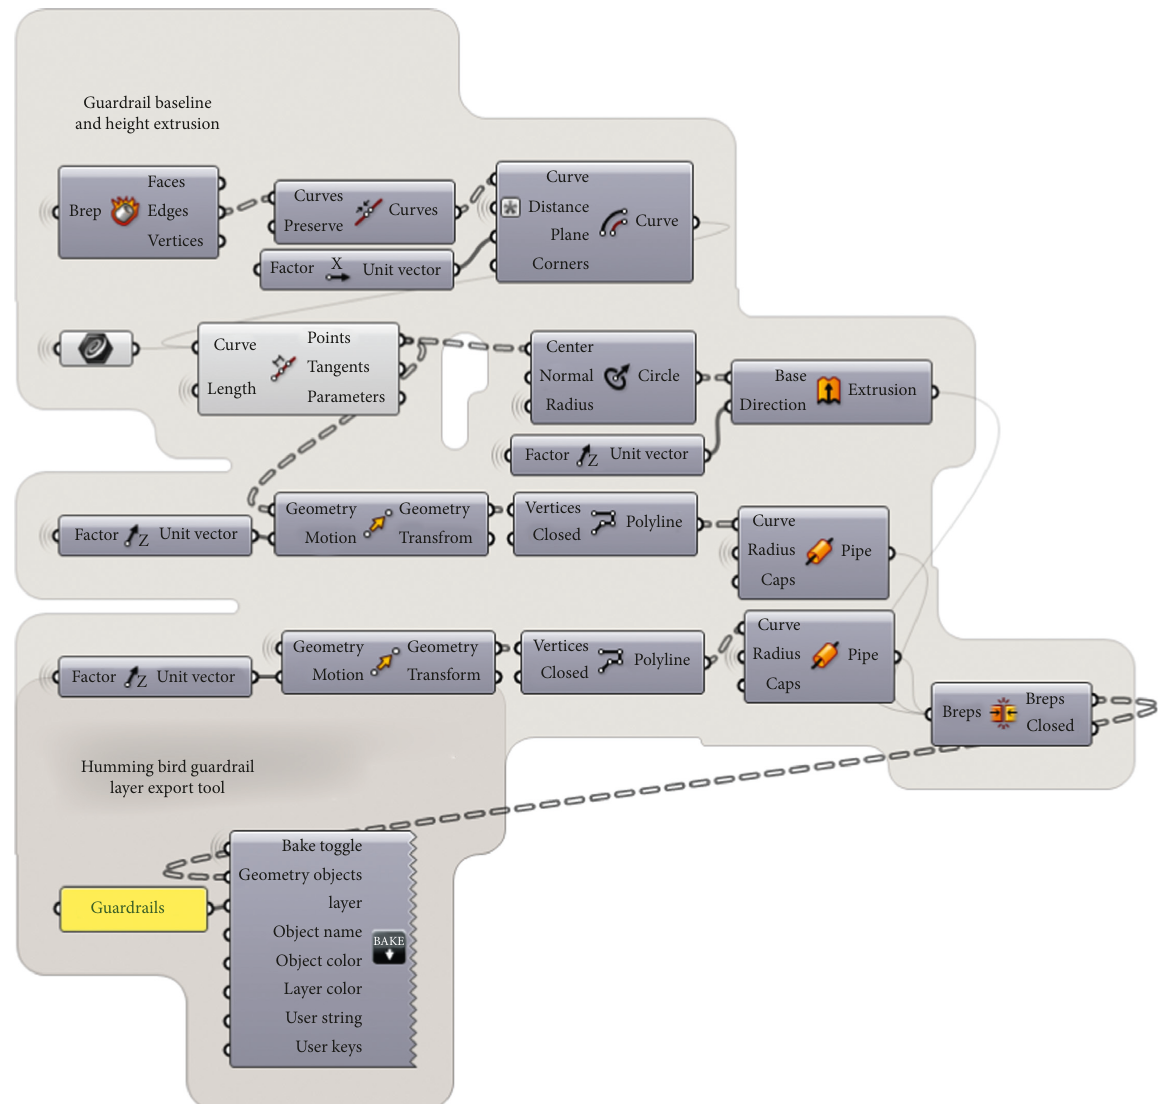
Figure 7: Algorithm for detecting fall hazards and required preventive solution